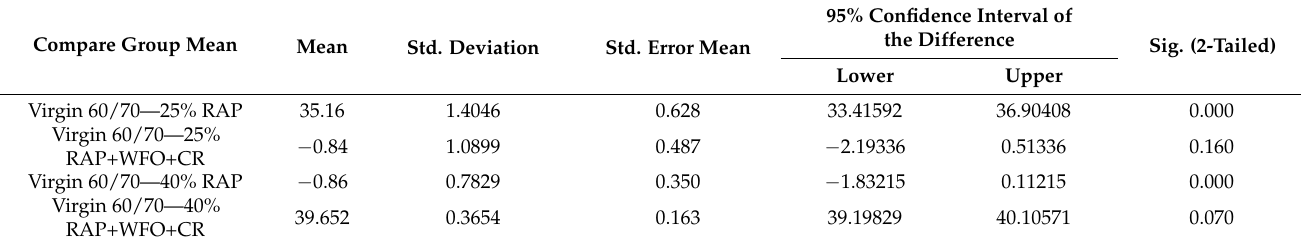
Table 4. Comparison of significant difference of group means for the penetration